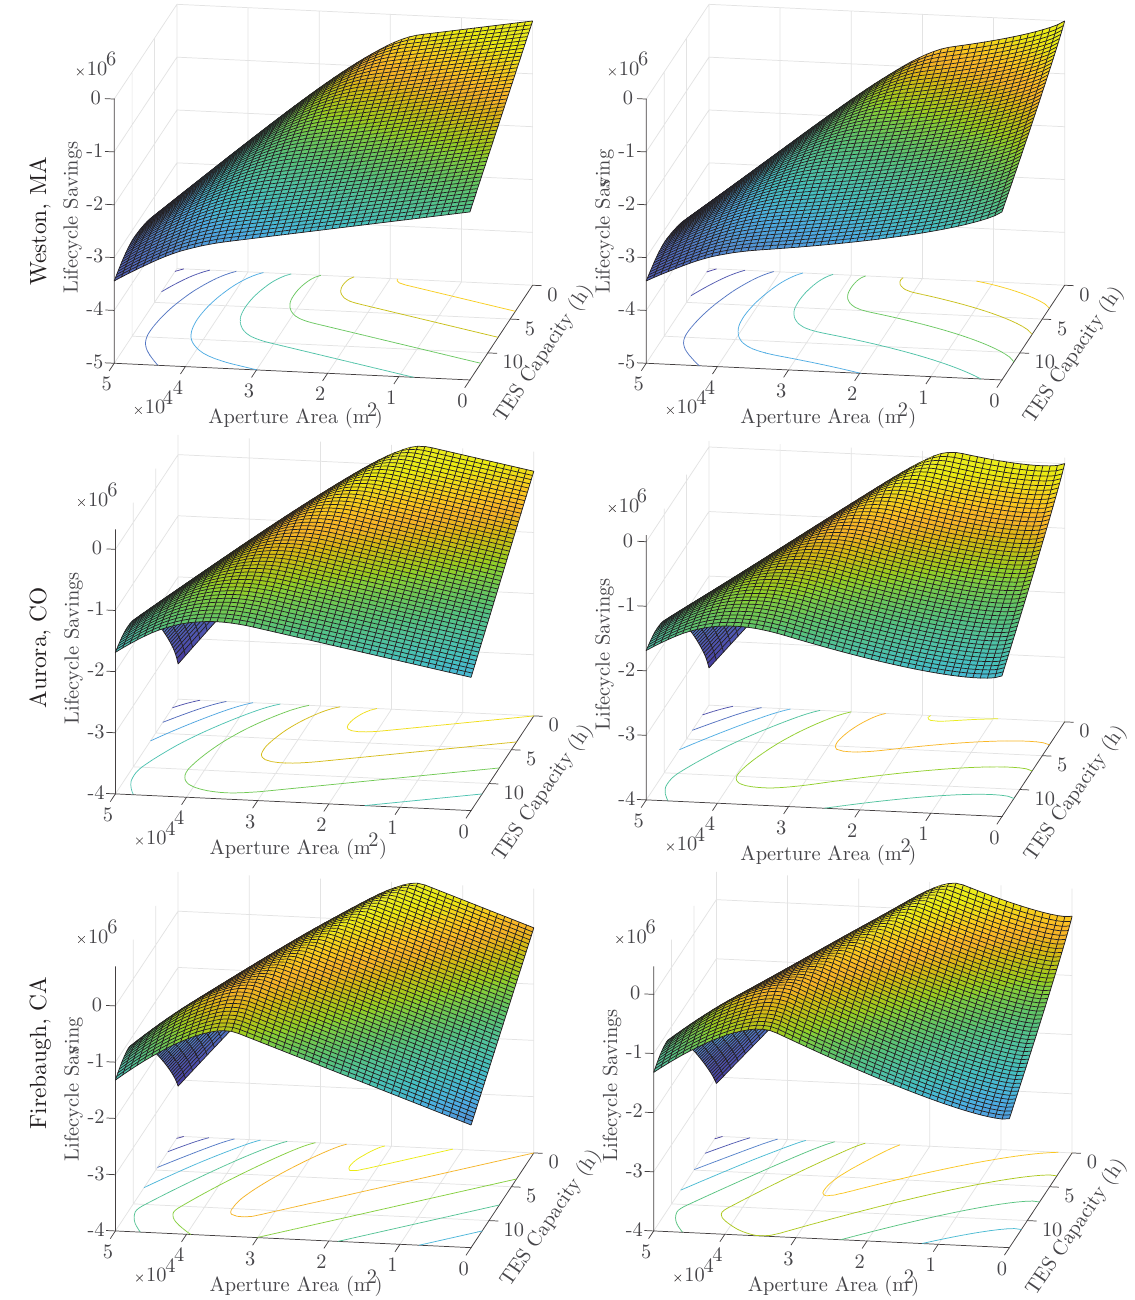
Figure 5. The objective function surfaces f fix ( left column ) and f disc ( right column ) for constant IPH LCS LCS demand for industrial fuel rates are plotted for each geographic location. The discount-pricing model exhibits nonconvexity in all cases and suboptimal local minima for Aurora and